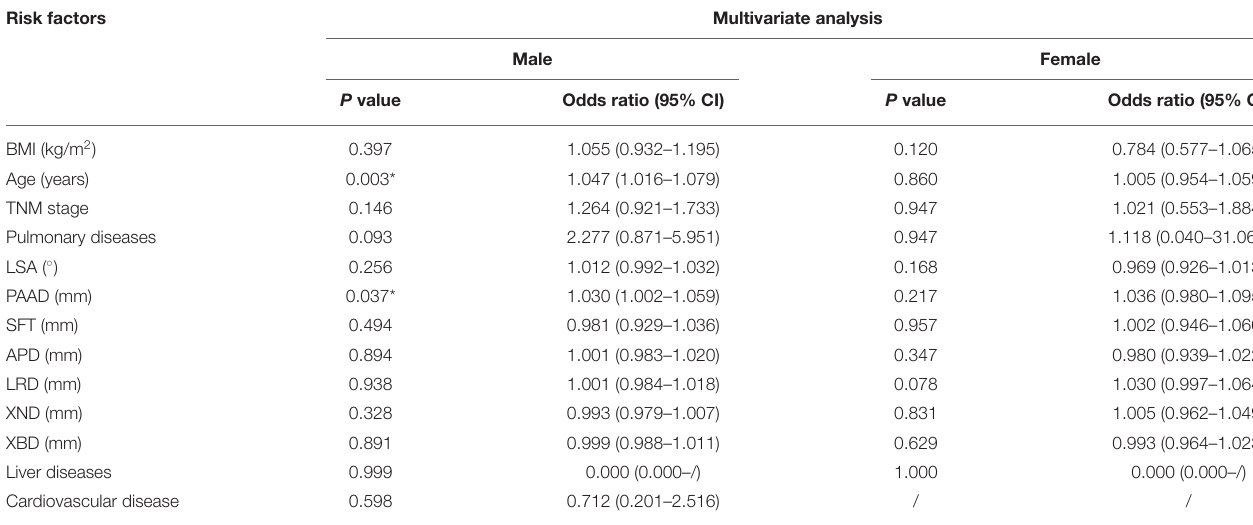
TABLE 6 | Multivariate analysis of predictive factors for postoperative